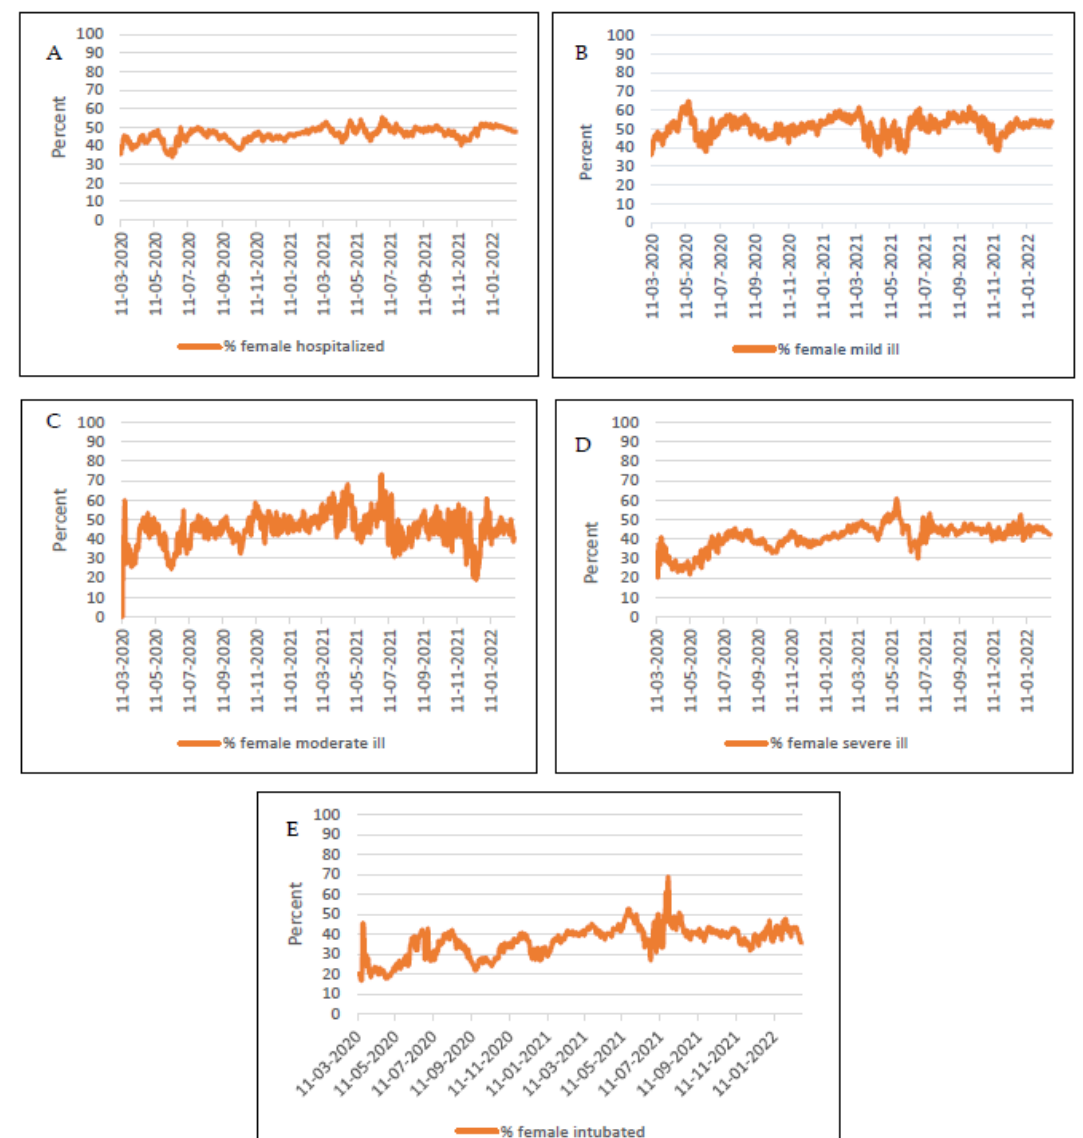
Figure 2. Gender trends in morbidity through five parameters including ( A ) hospitalization (out of all hospitalized), ( B ) mild, ( C ) moderate and ( D ) severe illness (among each respective population), and ( E ) intubation (among all intubated) throughout two years of the pandemic. The % males of each variable are the mirror reflection to the above data. Notes: The differences in all five trends are statistically significant according to the independent t -test. Statistical significance was defined as x <